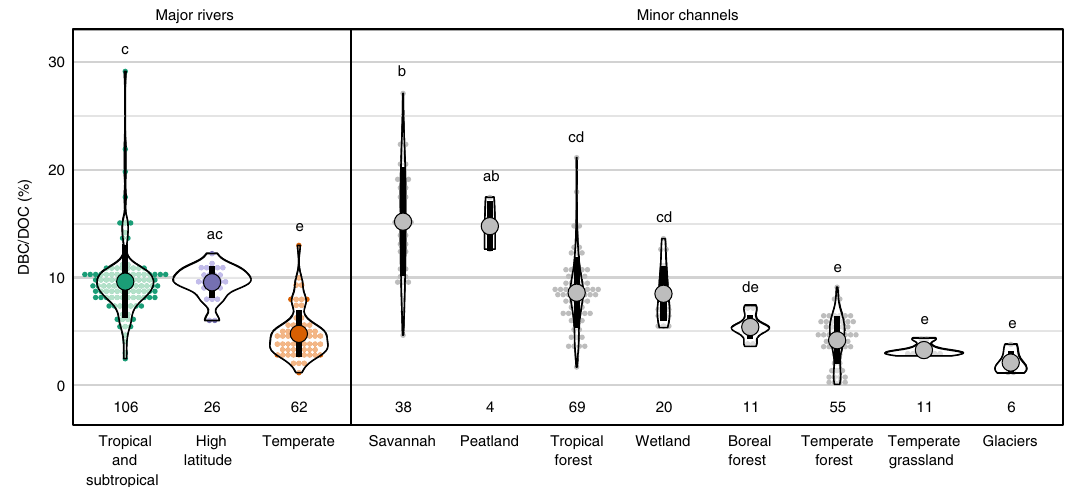
Fig. 2 Dissolved black carbon (DBC) content of dissolved organic carbon (DOC; %). Each observational value (see Supplementary Dataset) is marked as a small dot and classi fi ed by channel type. These observations are stacked horizontally as in a histogram with a grouping interval of 0.5%, while the violin plot marks the kernel probability density at the range of observed values. The mean and standard deviation of observed values are marked by a large dot and thick black line, respectively. The number of data points included in each channel class is also shown. Letters denote groups with statistically similar mean values according to Tukey honest signi fi cant difference (HSD)